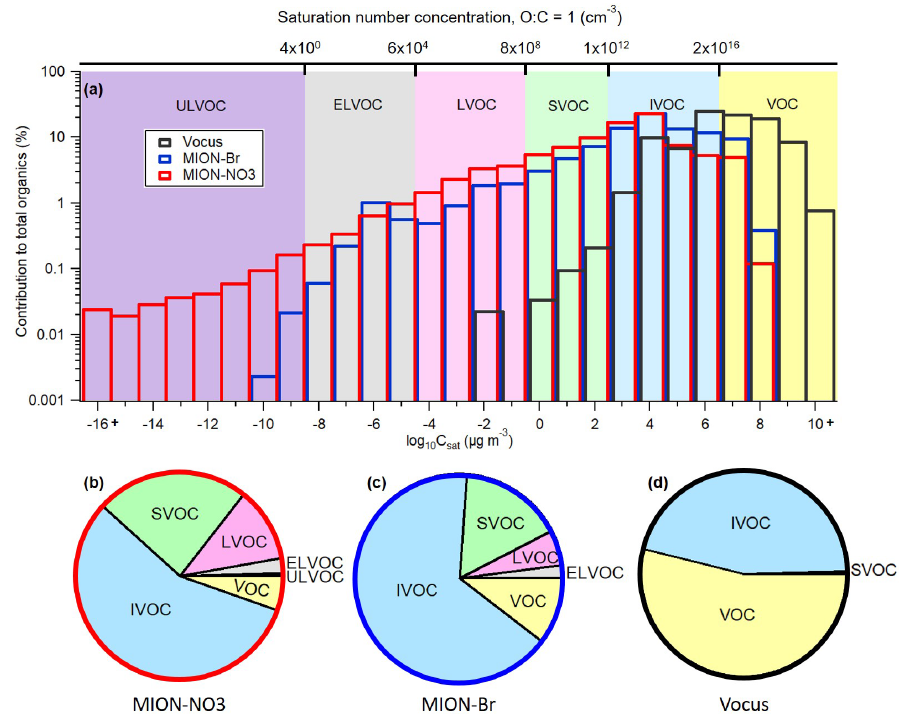
Figure 6. (a) Volatility distribution comparison for organic compounds detected by different measurement techniques and parameterized with the modified Li et al. (2016) approach (Daumit et al., 2013; Isaacman-VanWertz and Aumont, 2021); resulting pie charts for the contributions of VOC, IVOC, SVOC, LVOC, ELVOC, and ULVOC classes for MION-NO 3 (b) ; MION-Br (c) ; and Vocus (d) . Contributions of LVOC for Vocus (0.02 ± 0.01%) and ULVOC for MION-Br (0.02 ± 0.04%) were not labeled in the pie chart.